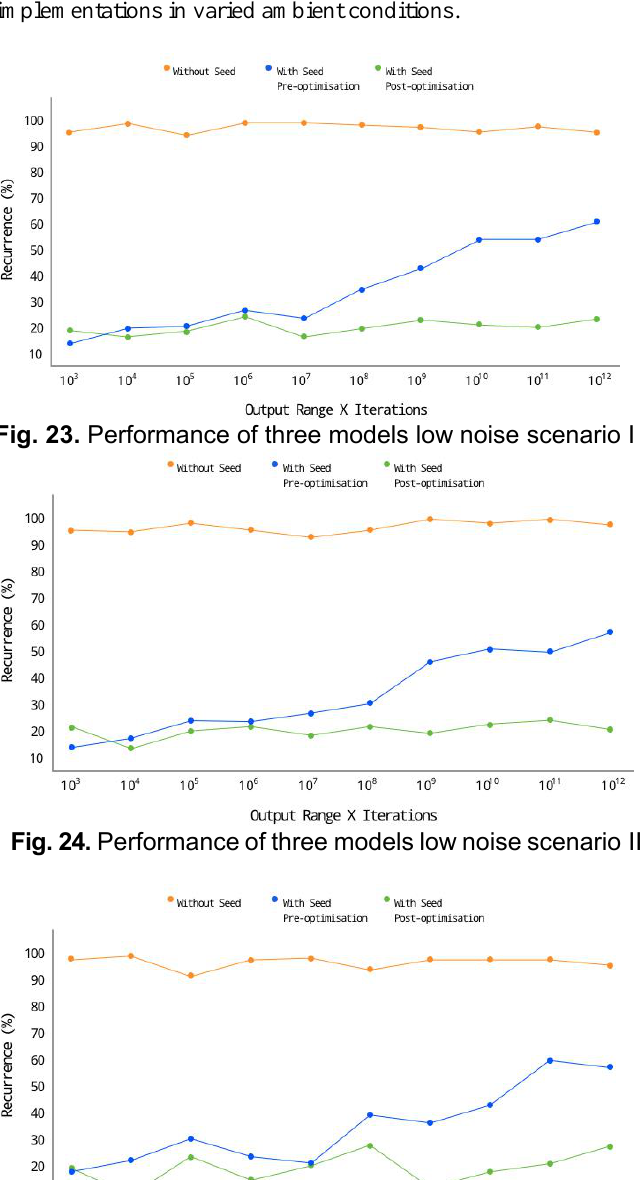
Fig. 25. Performance of three models low noise scenario III